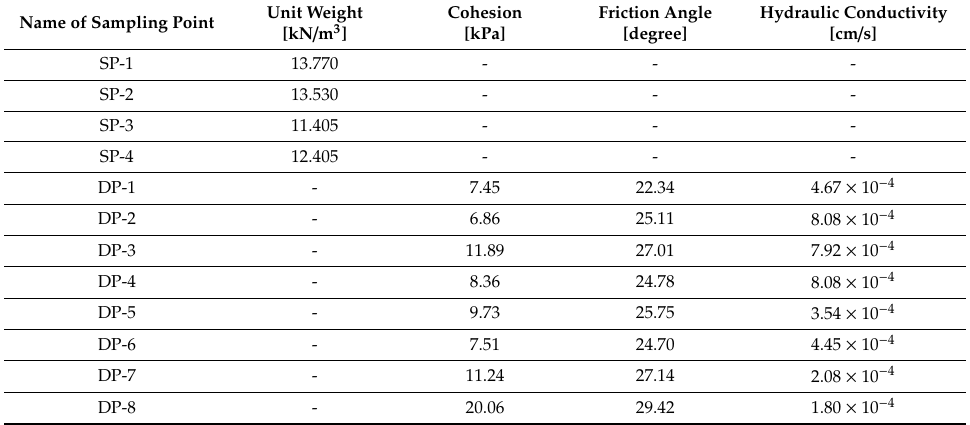
Table 2. Geotechnical properties of unit weight, cohesion, friction angle, and hydraulic